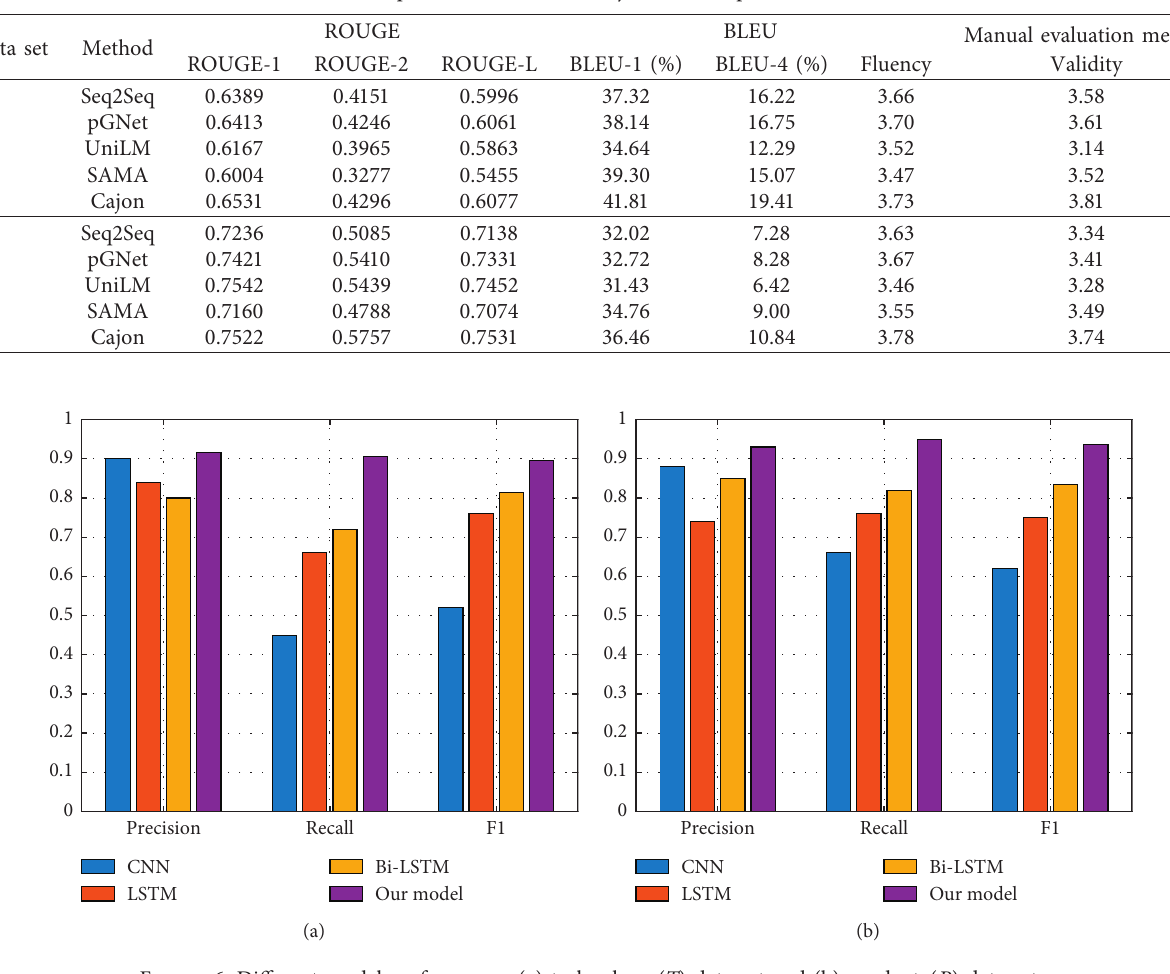
Figure 6: Different model performance: (a) technology ( T ) data set and (b) product ( P ) data